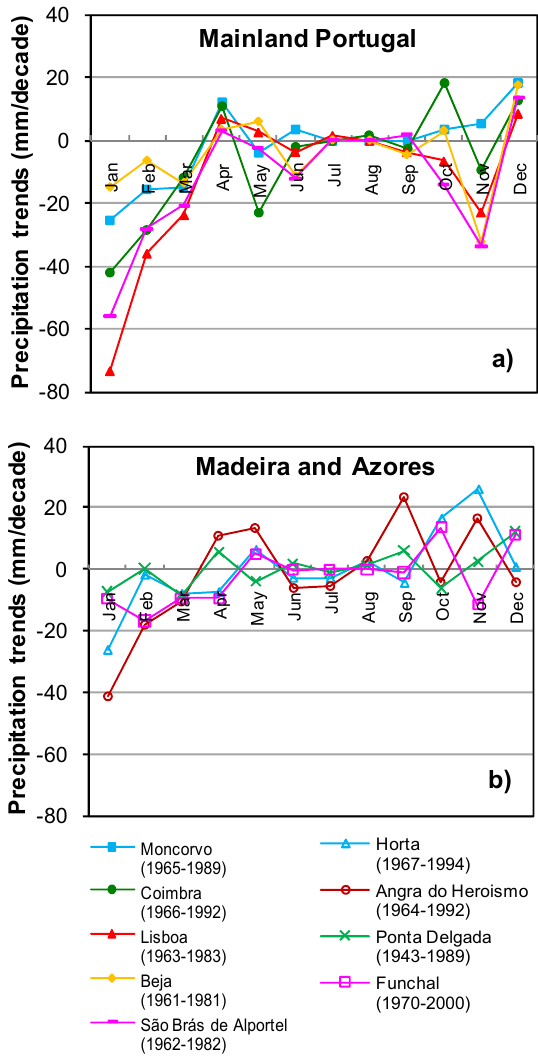
Fig. 5. Monthly precipitation trends in selected periods for: (a) five locations in mainland Portugal; (b) four locations in Azores and Madeira. The periods analysed are identified in the legend and were selected based on the partial trend analyses and results, and correspond to decreasing trend sub-periods in annual precipitation.